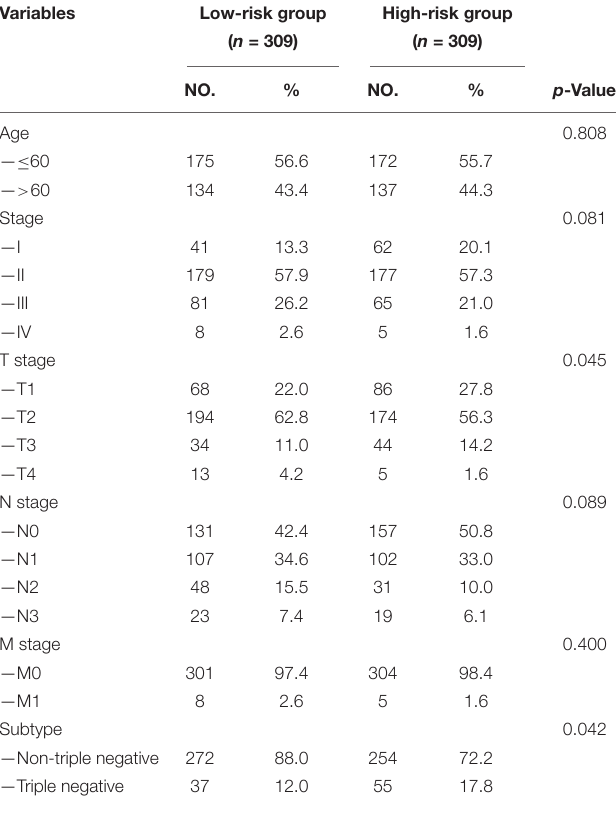
TABLE 2 | The association between risk score and patients’ clinical features in the training